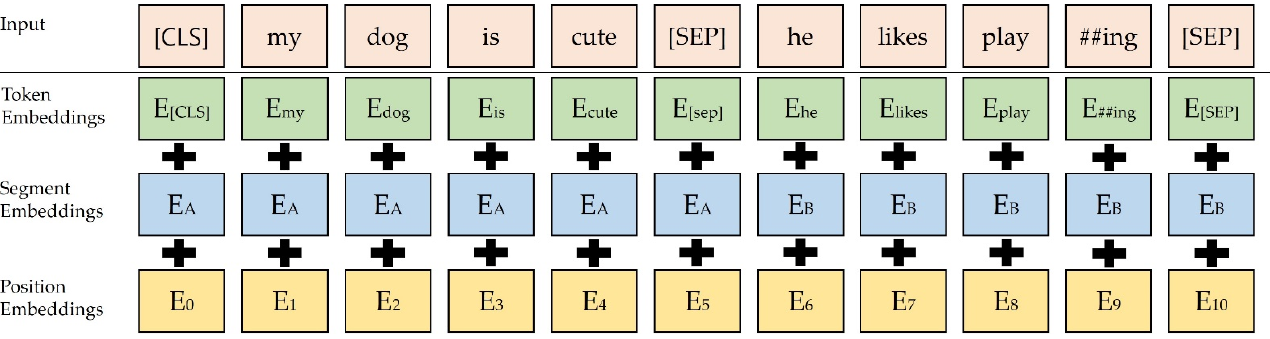
Figure 6. Input embedding of BERT (cited from [30]).